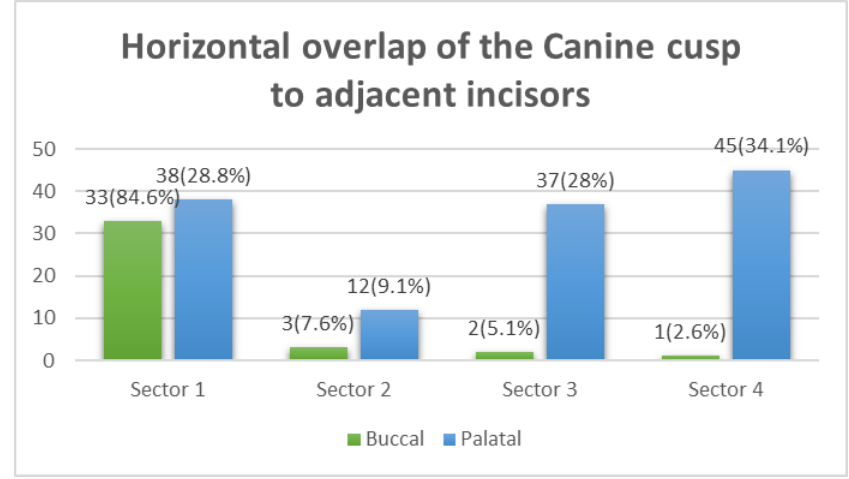
Figure 6. Comparison between buccal – palatal canine impaction and the horizontal overlap of the impacted canine crown tip with adjacent teeth using the chi-square test (X 2 = 40.7, df = 3, p < 0.001 *). * Statistically significant at p ≤ 0.05.